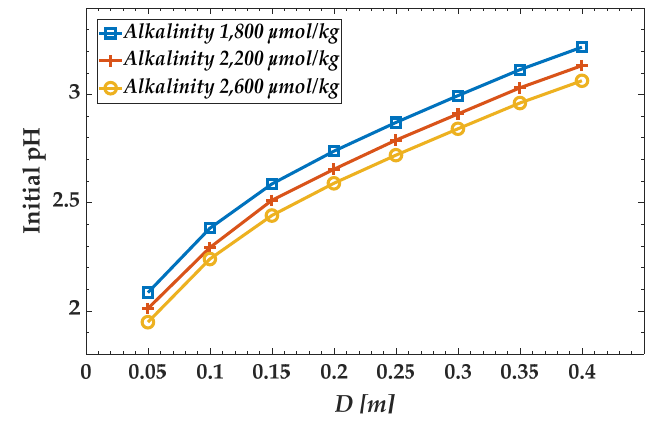
Figure 10. Variation in the treatable initial pH with the designed nozzle diameter under different seawater alkalinity values.